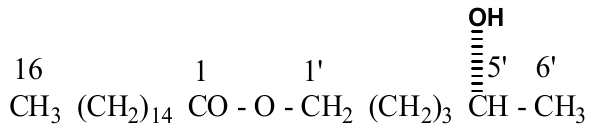
Figure 6. The diagnostic MS/MS fragmentation at m/z 792 full ESI-MS scan of the isolated compound 5 ′ -hydroxyhexyl n-hexadecanoate.